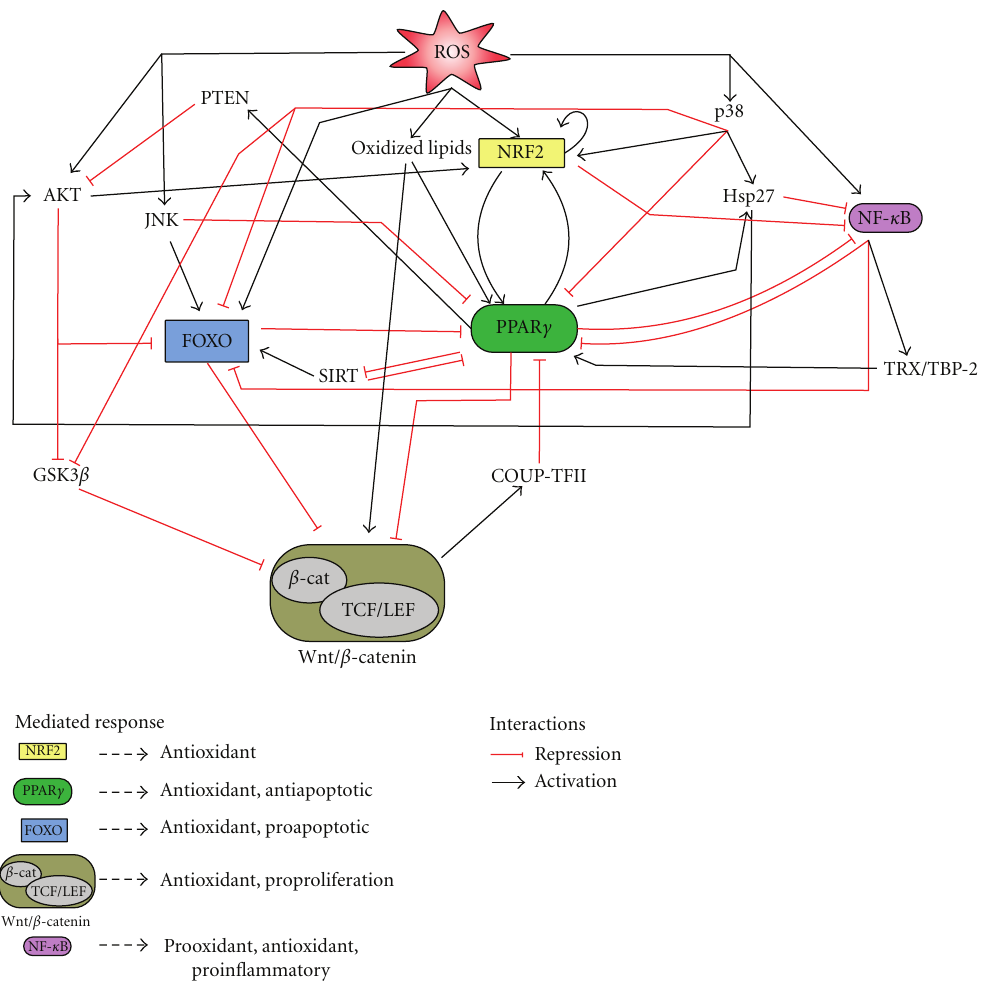
Figure 2: Crosstalk of PPAR γ with NRF2, Wnt/ β -catenin, and FOXO signaling pathways in oxidative stress response. ROS and other reactive species activate NRF2 and PPAR γ that are linked by a positive feedback loop that sustains their expression. Through a negative feedback PPAR γ inhibits Wnt/ β -catenin and induces cell block. Activation of FOXO in turn blocks Wnt/ β -catenin (diverting β -catenin from proliferation to resistance and apoptosis) and PPAR γ . Finally, the result of these interactions, survival or cell death, depends on the action of other signaling pathways and regulatory